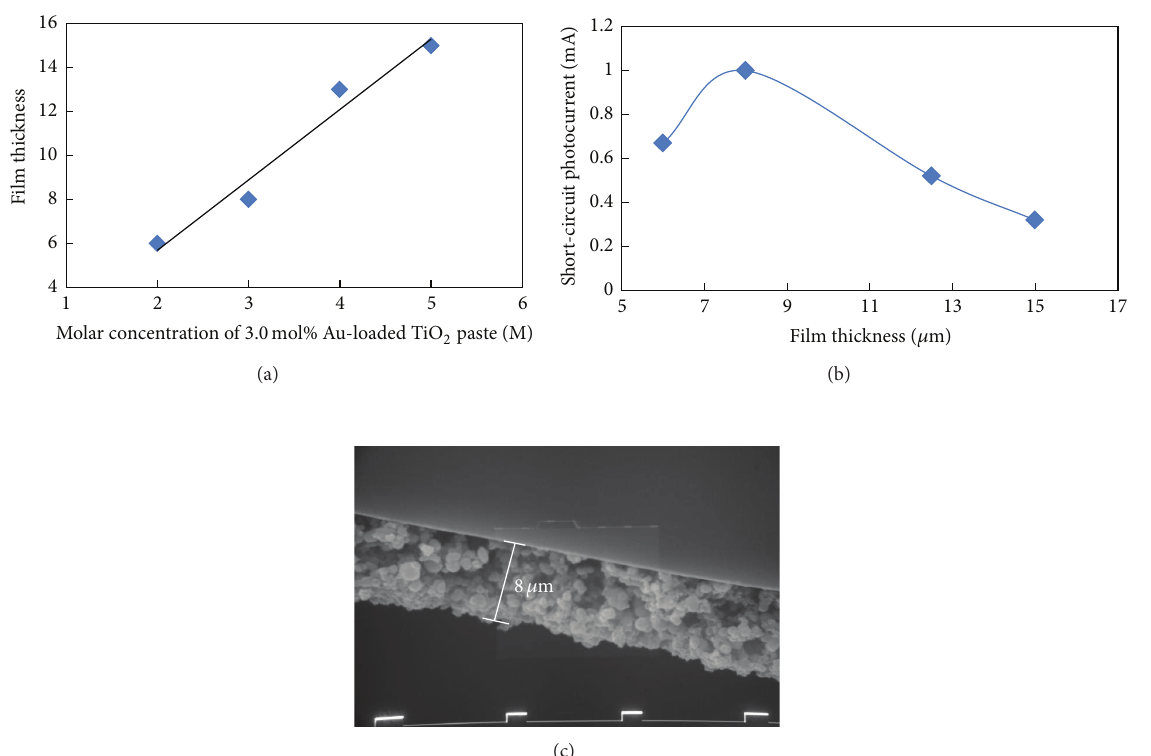
Figure 7: (a) Molar concentration of TiO 2 paste versus film thickness of 3.0 mol% Au-TiO 2 film. (b) Film thickness versus short-circuit photocurrent of 3.0 mol% Au-TiO 2 film. (c) SEM image of 3.0 mol% Au-TiO 2 film prepared by squeegee method with using 3M TiO 2